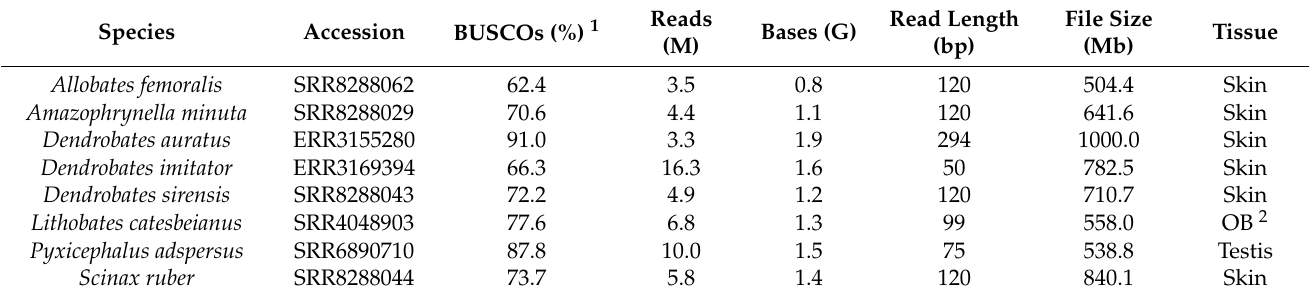
Table 2. Test NGS Dataset from NCBI SRA